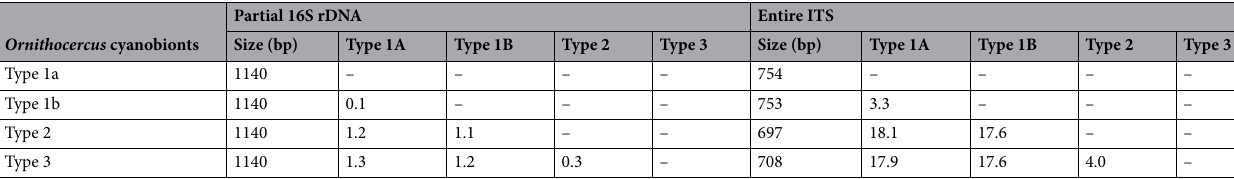
Table 1. A genetic p-distance matrix of the partial 16S rDNA and entire ITS gene in three genetic types of Ornithocercus cyanobionts sampled in this